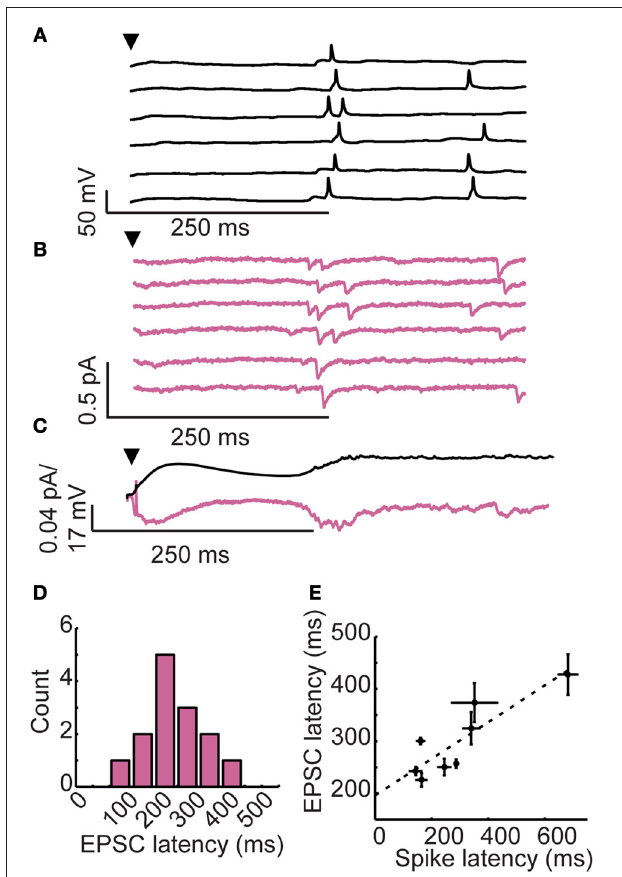
FIGURE 2 | Long-latency granule cell activity is driven by late onset excitatory inputs. (A) Membrane voltage and (B) membrane currents of a single granule cell following brief glomerular stimulation (arrowhead). Six trials shown. (C) Membrane potential (upper) and somatic currents (lower) averaged across trials. (D) Distribution of EPSC onset across cells. (E) Correlation between first spike latency and EPSC latency across cells.